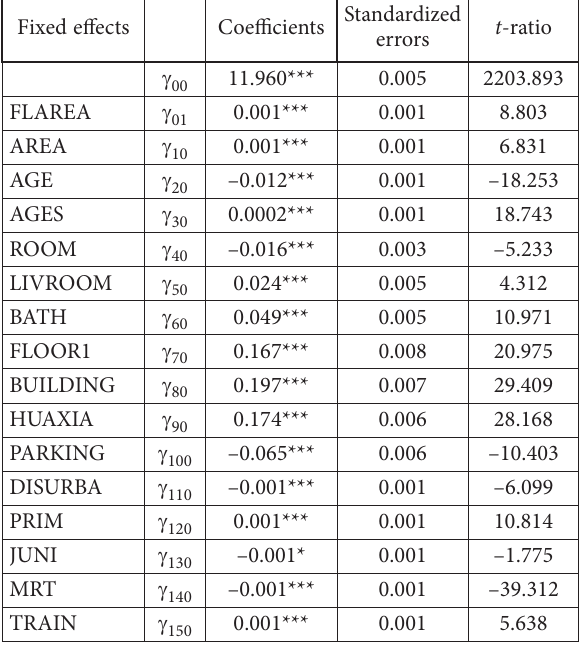
Table 4. Empirical estimation